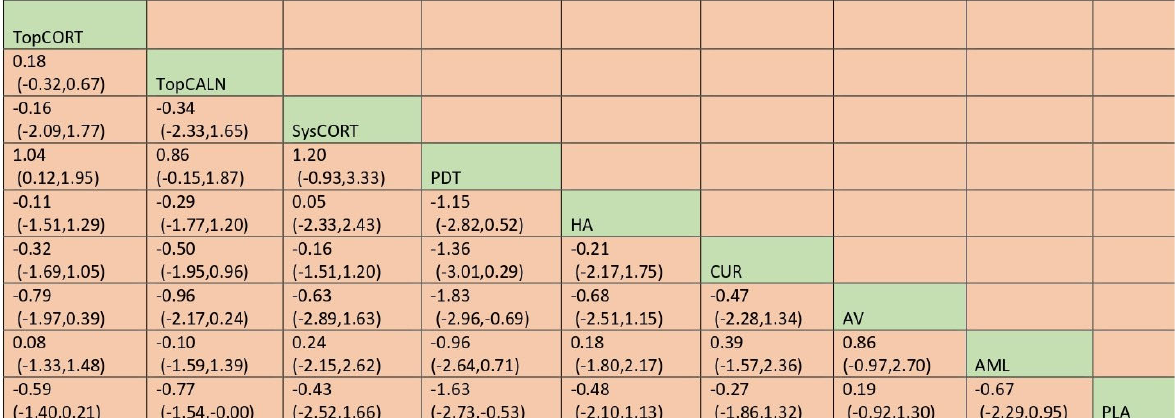
Figure 12. Network Plot: Pain Score. Abbreviations: AML, amlexanox paste; AV, aloe vera; CUR, curcumin gel; PDT, photodynamic therapy; PLA, placebo; PUR, purslane; SysCORT, systemic corti- costeroid; TopCALN, topical calcineurin; TopCORT, topical corticosteroid; HA, hyaluronic acid.